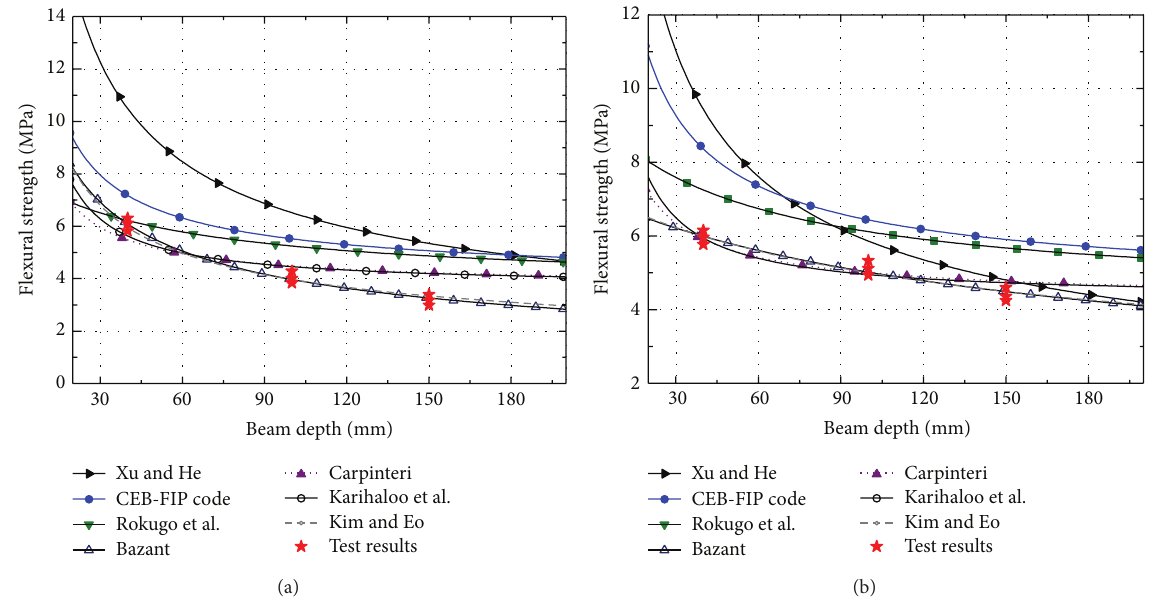
Figure 8: Comparison of test data with existing scaling laws: (a) cement mortar; (b)